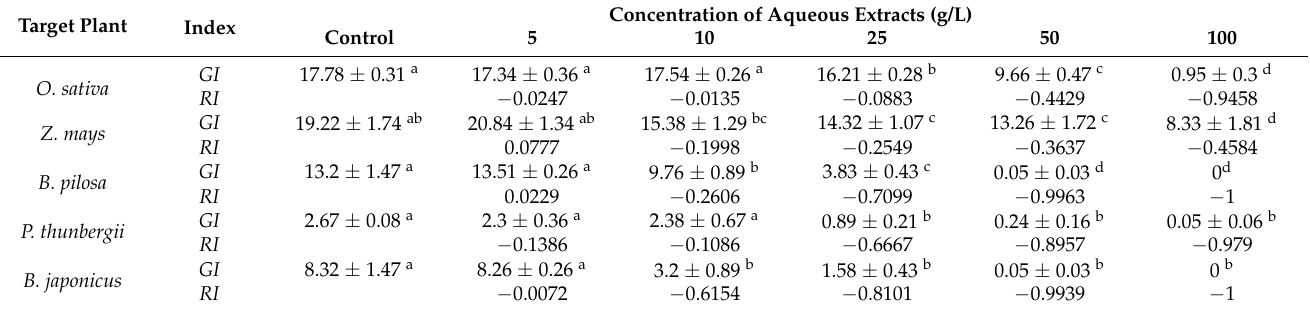
Table 2. Effects of fleagrass aqueous extracts on the seed germination indices of five target